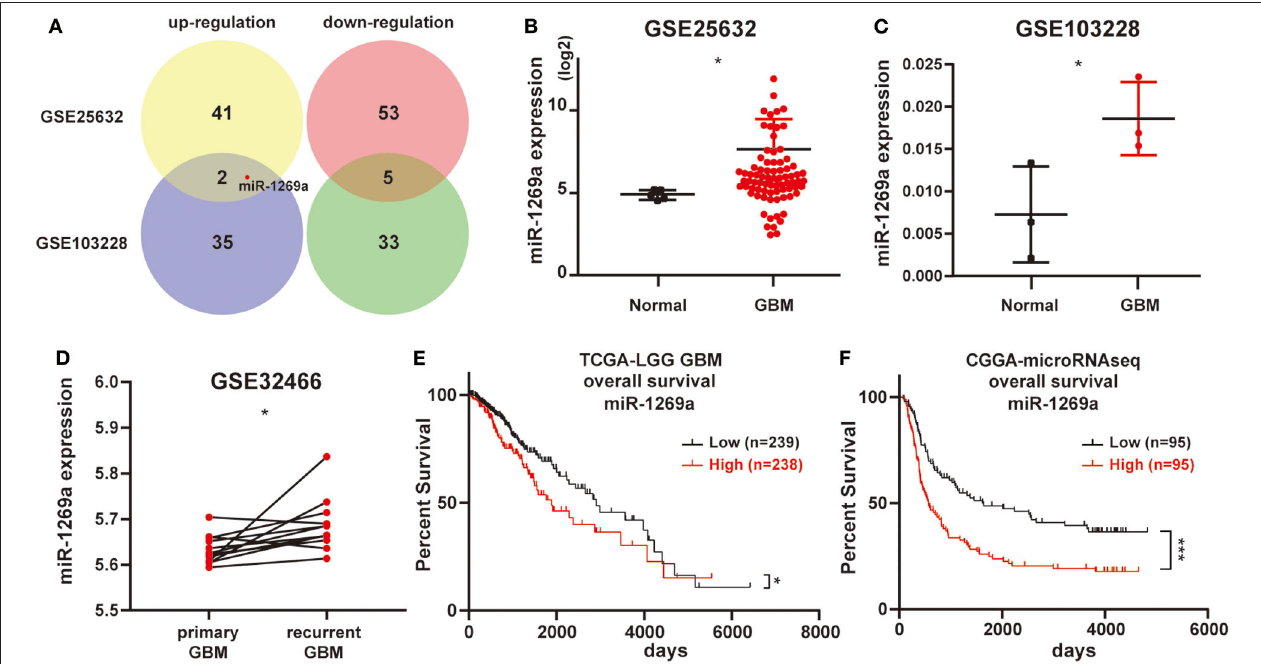
FIGURE 1 | High levels of miR-1269a expression are associated with poor prognosis of glioma patients in datasets. (A) The miRNA microarray of glioblastoma samples was obtained from the Gene Expression Omnibus database (GSE25632 and GSE103228). (B–D) The expression levels of miR-1269a in glioma based on the GSE databases. (E,F) Overall survival according to high or low miR-1269a expression levels in the TCGA and CGGA databases. The median value was used as the boundary of the high and low expression levels of miR-1269a. All data are shown as mean ± SD. * P < 0.05, and *** P <